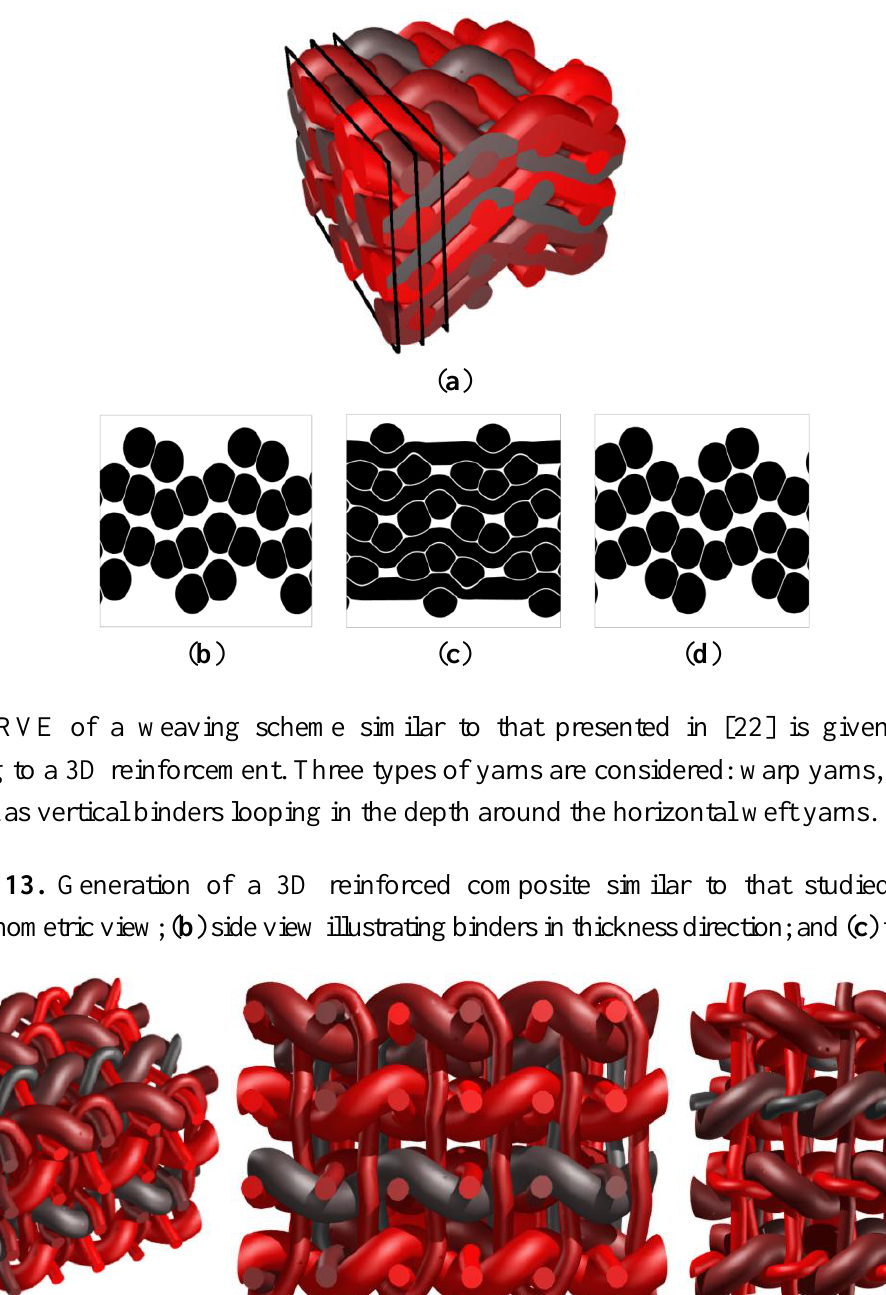
Figure 12. Woven composite with post-processing of the weave configuration to reach contact between yarns; ( a ) axonometric view; and ( b – d ) cuts of the weave perpendicular to the warp yarns.